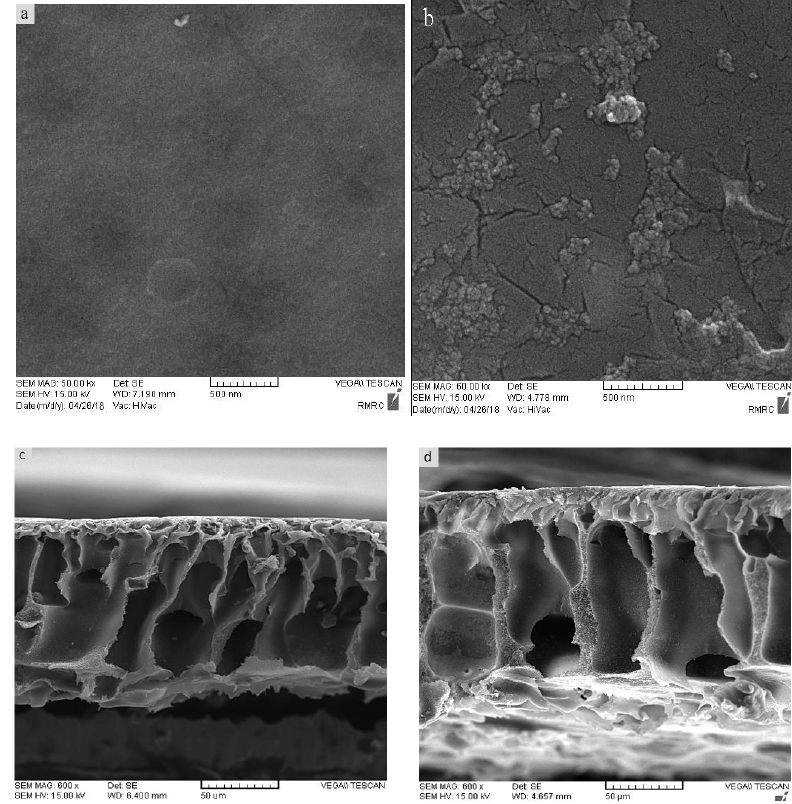
Figure 3. SEM images of prepared membranes’ surface: ( a ) PSF/and ( b ) PSF modified with GO/Pt (0.75 wt%) nanoparticles; cross-sectional SEM images of ( c ) PSF and ( d ) PSF modified with GO/Pt (0.75 wt%) nanoparticles.